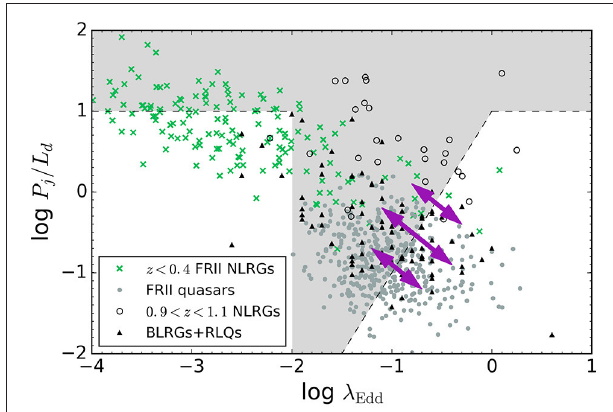
FIGURE 1 | The dependence of P j / L d on the λ Edd for all samples: z < 0.4 FRII NLRGs as green crosses; FR II quasars as grey dots; 0.9 < z < 1.1 NLRGs as empty circles; BLRGs+RLQs as black triangles. The horizontal dashed line corresponds to P j = ( ǫ d / 0.1) ˙ Mc 2 . The inclined dashed line is derived from the Equation (2) for a = 0.5 and assuming a correct normalization. The presence of objects in the shaded region of the plot calls into question our underlying assumptions. Purple arrows show how the modulation of jet production affects the P j / L d − λ Edd